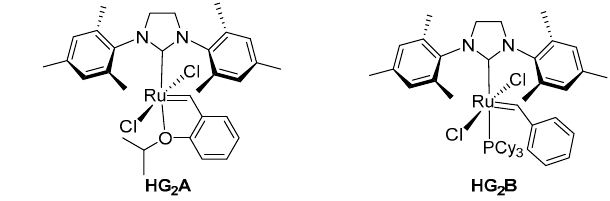
Figure 2. Hoveyda-Grubbs 2nd generation catalysts ( HG 2 ).